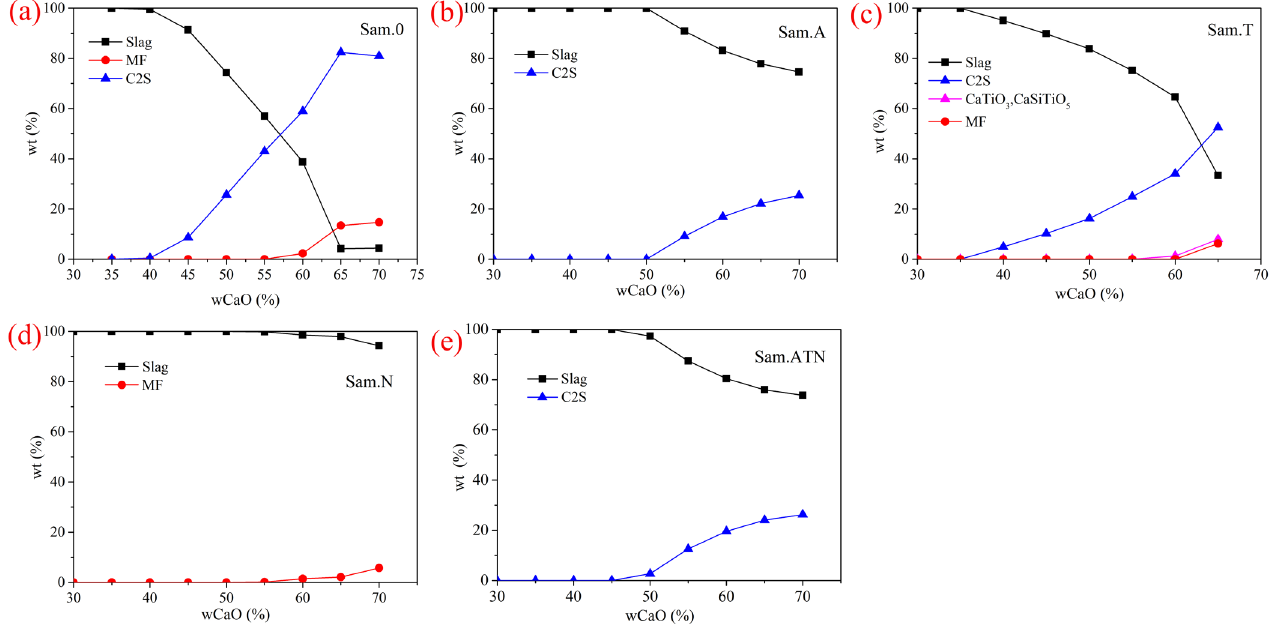
Figure 8. Theoretical phases in lime dissolution calculated by FactSage 7.0. (( a ) Sample 0, ( b ) Sample A, ( c ) Sample T, ( d ) Sample N, ( e ) Sample ATN).